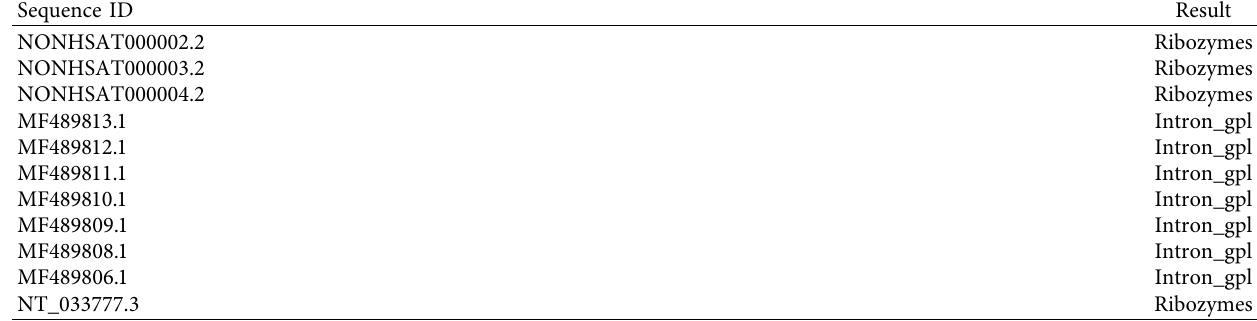
Table 4: The classification results of ncRDeep.